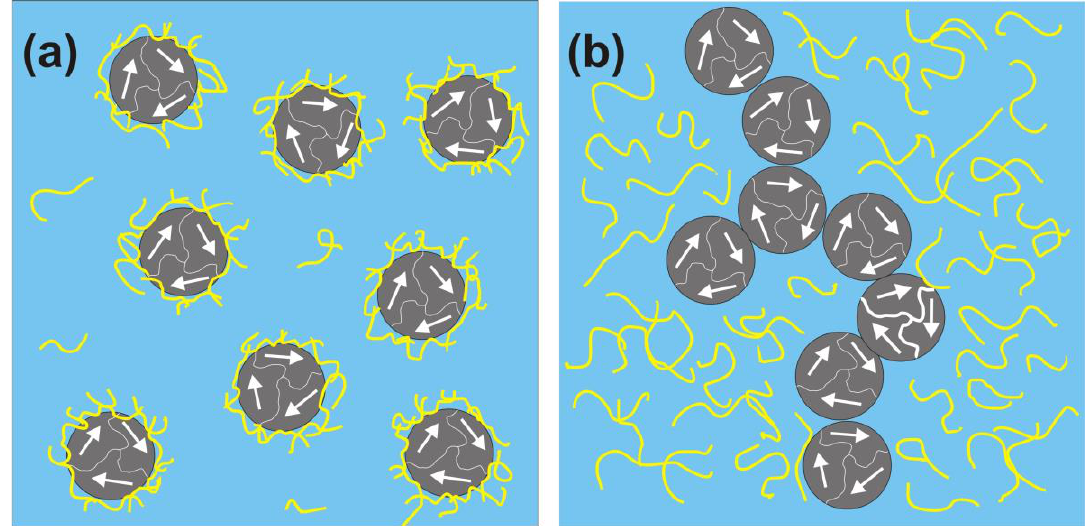
Figure 9. Schematic presentation of the two types of structuring in Na-alginate MRS with MPs depended on the interfacial adhesion among the particles and the polymer. ( a ) — strong adhesion between Na-alginate and MPs leads to the polymeric layers at the surface which favor fluid-type behavior. It is the case of Fe 3 O 4 and Ni@C MNPs. ( b ) — weak interaction at the interface leads to the networking of MPs due to the magnetic forces which promote elastic deformation and the gelation of MRS. It is the case of Fe and Ni MPs.